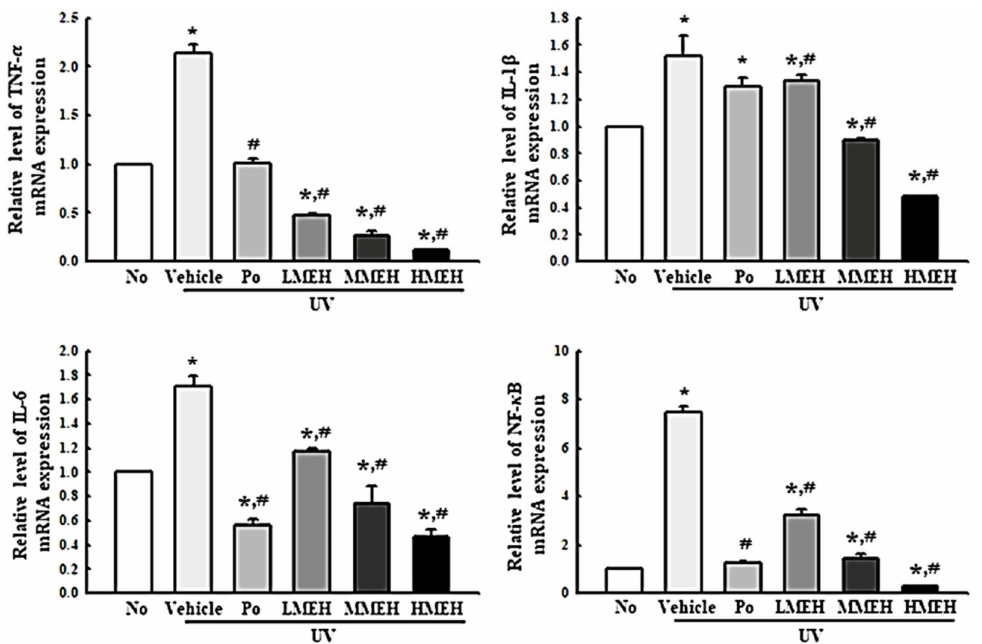
Figure 12. Level of the inflammatory cytokines in normal human dermal fibroblasts. Three dishes per group were used to prepare the total RNA. RT-qPCR analysis was performed in triplicate. This experiment was performed for three times and results are the average of all experiments. The data are reported as the means ± SD of triplicate. *, p < 0.05 compared to the untreated group. #, p < 0.05 compared to the UV + Vehicle group. Abbreviations: TNF- α , tumor necrosis factor α ; IL-6, Interleukin 6; IL-1 β , Interleukin 1 β ; NF- κ B, Nuclear factor kappa light chain enhancer of activated B cells; UV, Ultraviolet; RT-qPCR, Quantitative reverse transcription PCR; Po, Positive control; MEH, Methanol extract of Hygrophila erecta (Brum. F.)